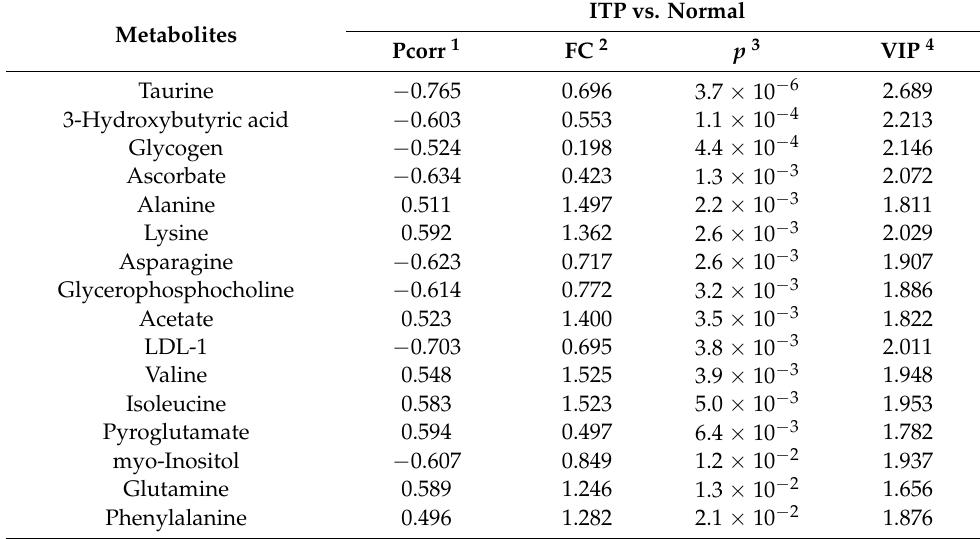
Table 2. The spleen discriminatory metabolites between the ITP patients and the